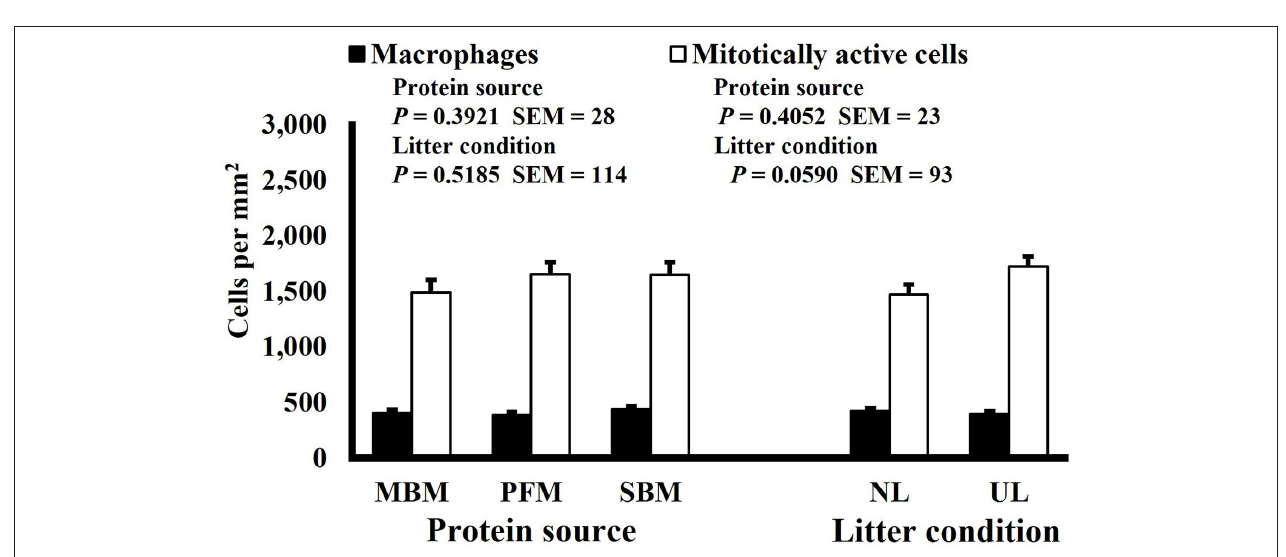
FIGURE 7 | Effect of dietary protein source and litter condition on macrophage (KUL01 + ) and mitotically active (BrdU + ) cell densities (cells per mm 2 ) in the ileum of 8-d-old broilers ( n = 36 per sampling d, 6 birds per treatment). MBM, meat and bone meal; PFM, 50% poultry by-product and 50% feather meal blend; SBM, soybean meal; NL, new litter; UL, used litter.